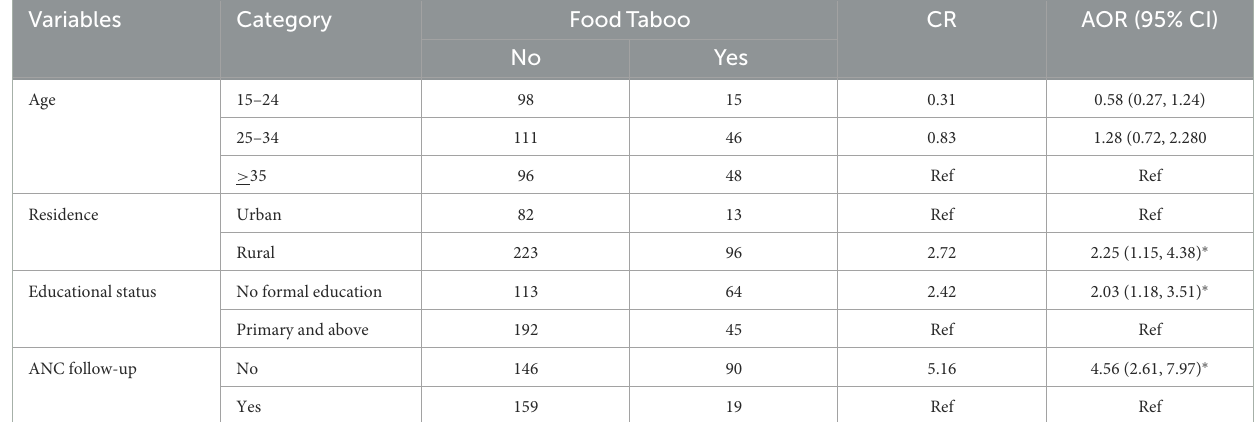
TABLE 3 Factors associated with food taboo during pregnancy among reproductive age women in southwest